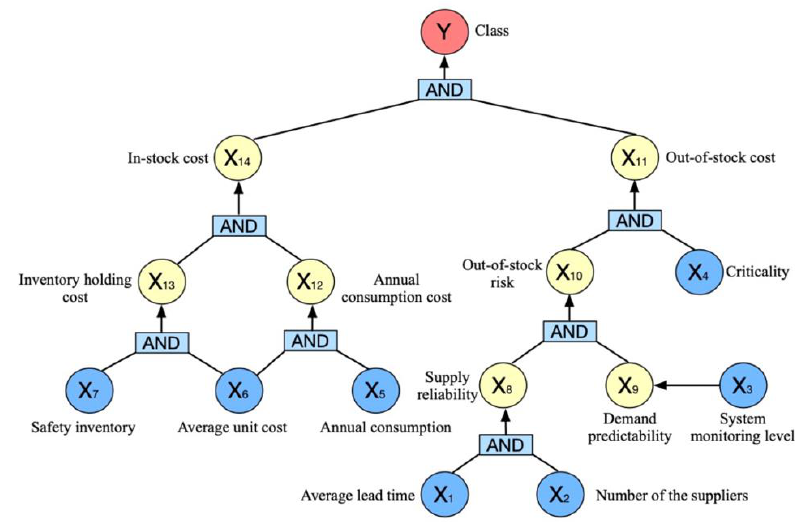
Figure 7. Hierarchical structure of the ship spare parts classification. For criteria, they can be scaled into different levels according to the data feature space. The original structure and distribution of criteria data for the spare parts are shown in Table 2. Table 2. The structure and distribution of the spare parts.